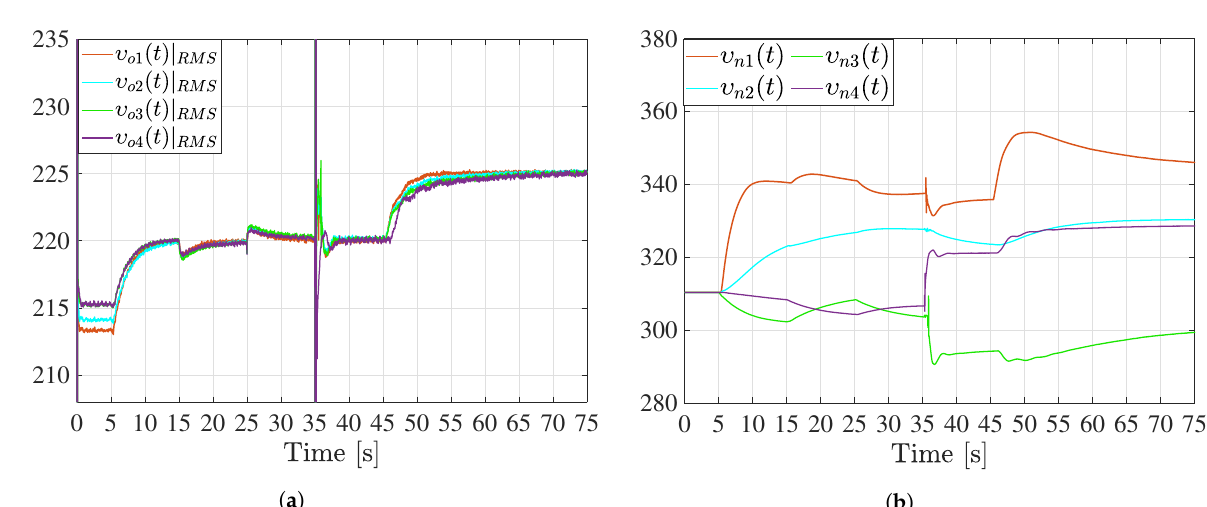
Figure 4. ( a ) RMS inverter’s output voltages; ( b ) Secondary voltage restoration control